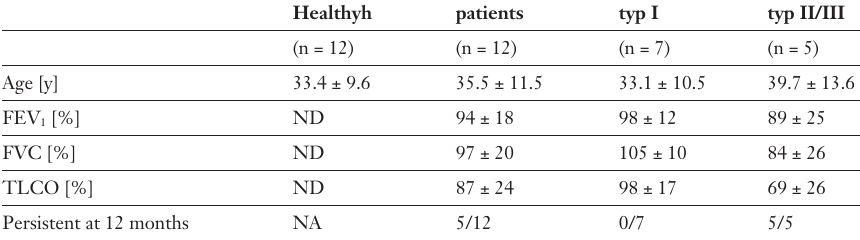
Subject characteris- tics including age, lung function para- meters and outcome at 12 months of clinical and radio- logical